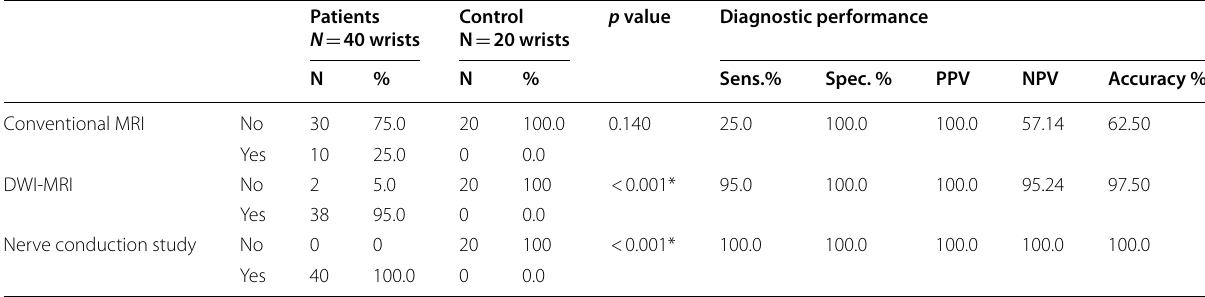
Sens . sensitivity, Spec . specificity, PPV positive predictive value, NPV negative predictive value